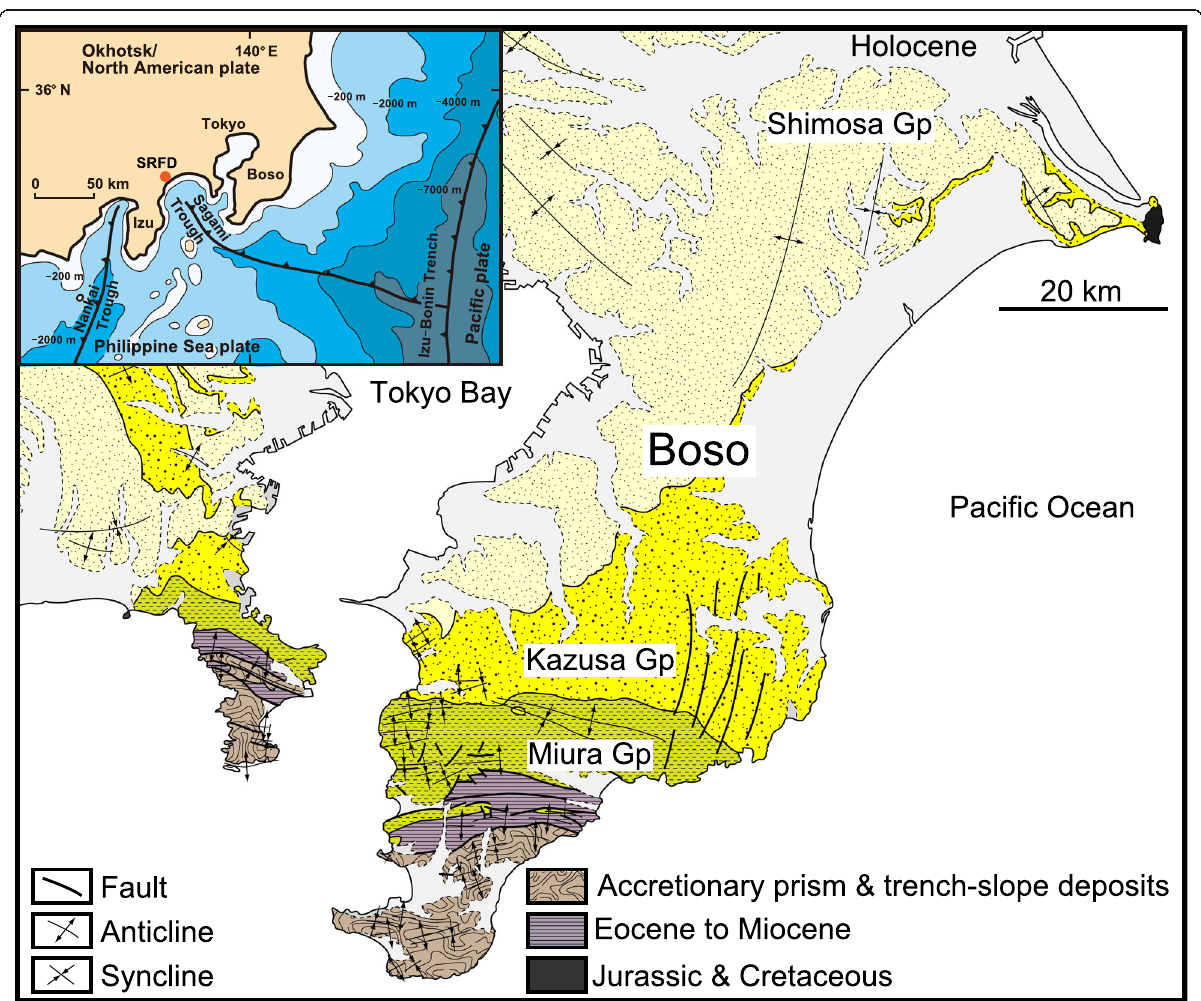
Fig. 1 Geologic sketch map of the Boso Peninsula and the adjacent area. Modified from Ito et al. (2016). The inset map shows the present-day plate-tectonic framework of the Boso Peninsula and its adjacent area (modified from Ito 2019). SRFD in the inset map denotes the location of the modern Sakawa River fan